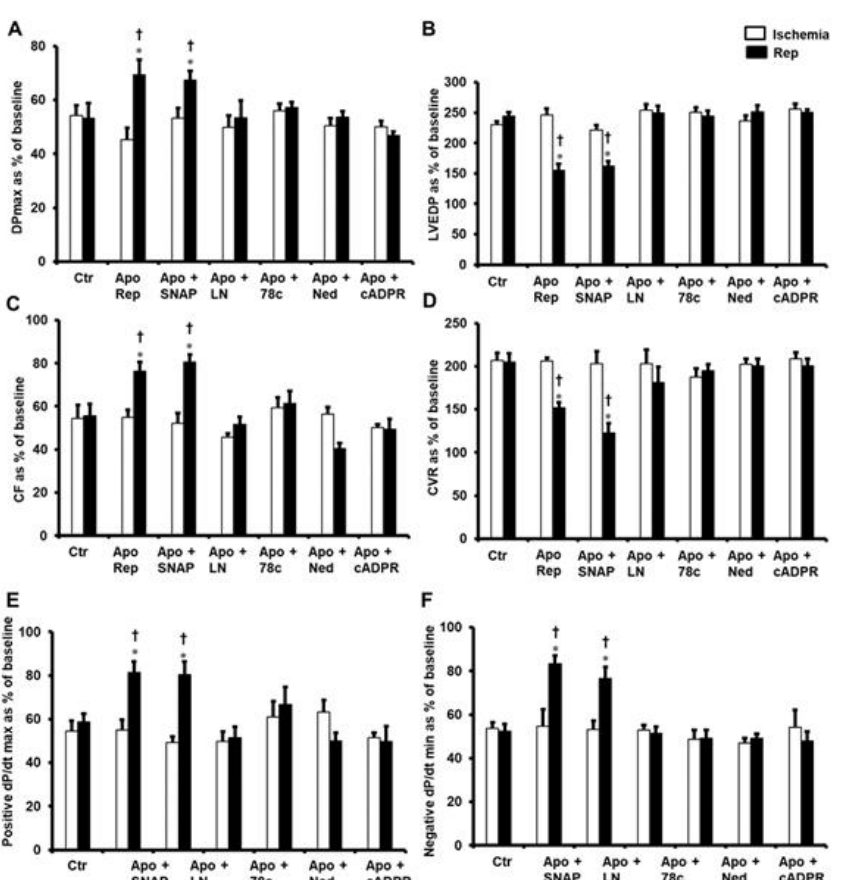
Figure 3. Post-ischemic recovery in cardiac hemodynamics after infusion of apocynin together with other inhibitors or agonists at reperfusion. Cardiac hemodynamics after the infusion of a combination of apocynin with SNAP, L-NAME, 78c, Ned, or cADPR agonist, presented as percentage of baseline (n = 8 per group). Data were obtained at the end of reperfusion and presented as means ± SEM. DPmax ( A ), maximum developed pressure; LVEDP ( B ), left ventricular end-diastolic pressure; CF ( C ), coronary flow; CVR ( D ), coronary vascular resistance; positive and negative dP/dt ( E , F respectively), contractility index; Ctr, controls; Apo, apocynin; SNAP, nitric oxide donor; LN, L-NAME; 78c, CD38 blocker; Ned, NAADP inhibitor; cADPR, cADPR agonist. * p < 0.05 compared to controls. † p < 0.05 compared to ischemia.